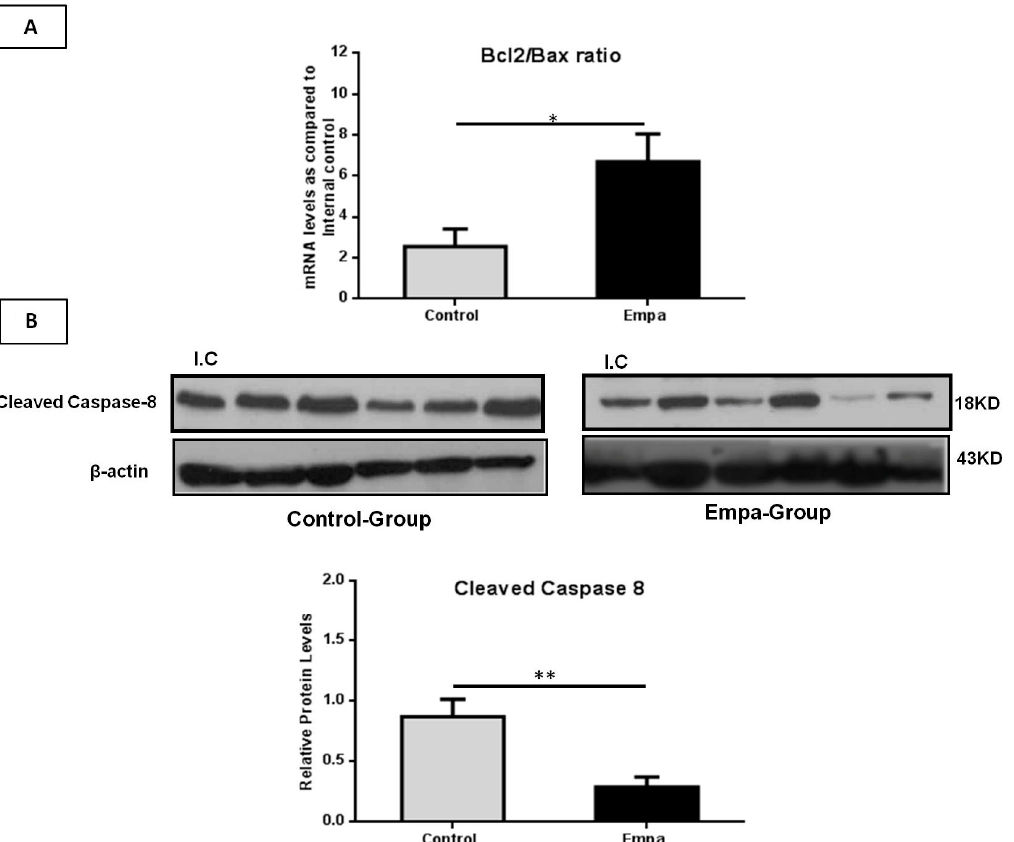
Figure 7. The mRNA and protein levels of apoptosis related molecules. ( A ) Empagliflozin treatment for five weeks significantly increased the mRNA Bcl2/Bax ratio. ( B ) Western blot analysis of cleaved caspase-8 with quantitative analyses showing that empagliflozin reduces the protein levels of cleaved caspase-8. Data are shown as the mean ± SEM (*: p < 0.05; **: p < 0.01; I.C: Internal control).